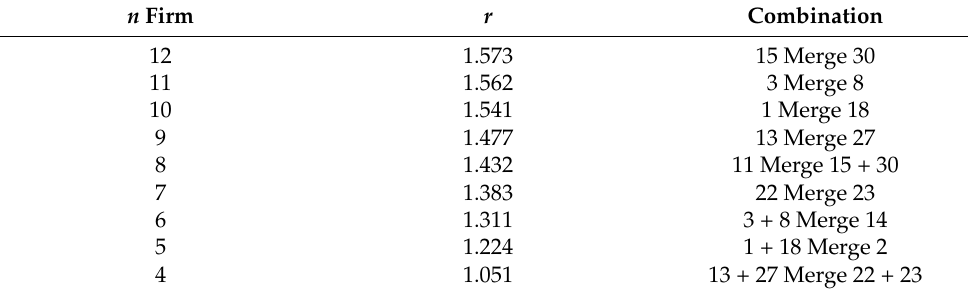
Figure 22. RSI for 4 firms’ setting (Cournot). Table 7. Cournot case study: optimal market structure.